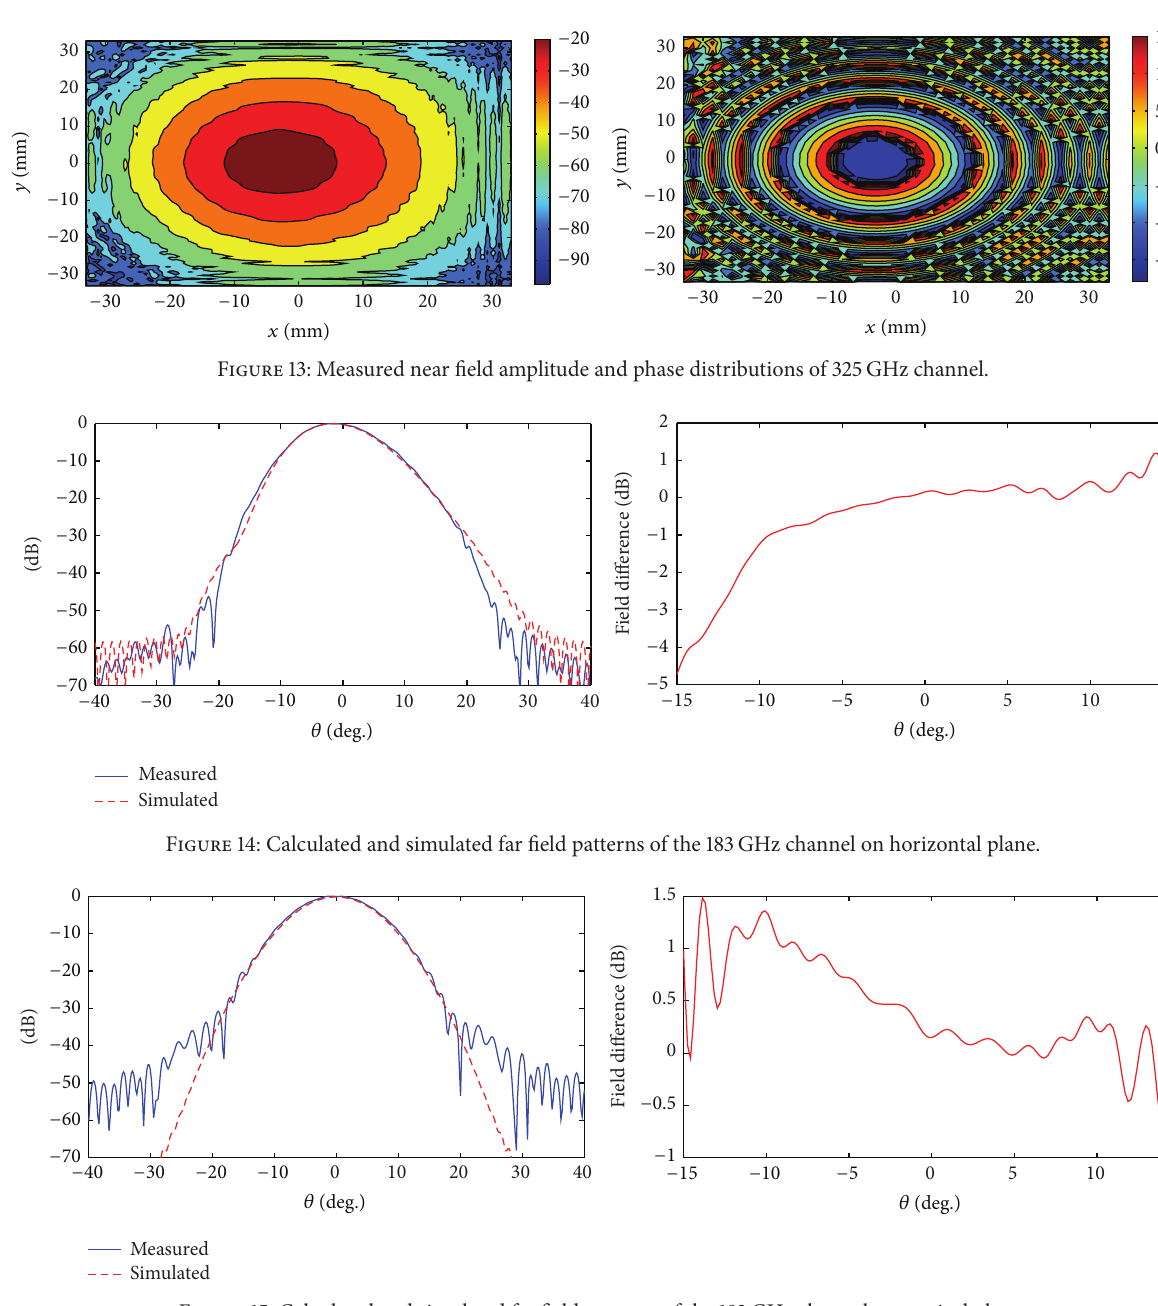
Figure 12: Measured near field amplitude and phase distributions of 183 GHz channel.